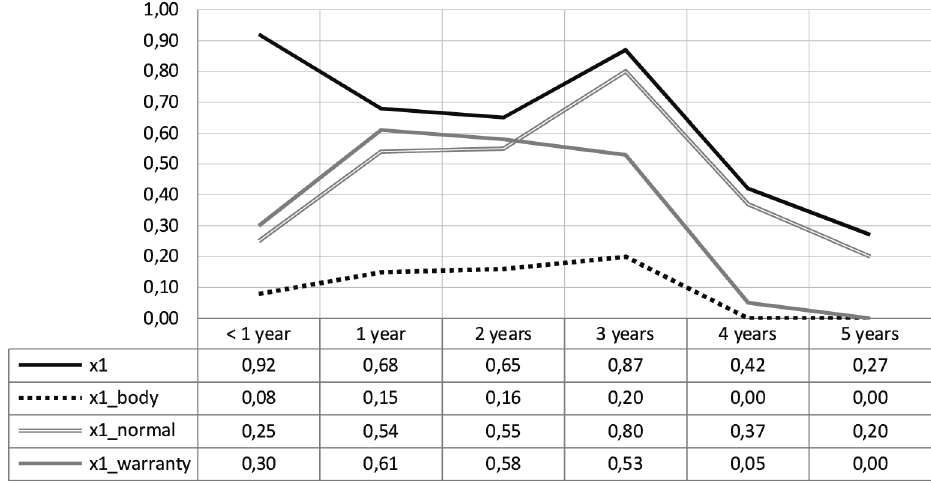
Figure 3. Summary of the SOSE retention indicator in 2018 for the brand x VIN in 2013−2018 in the studied organization